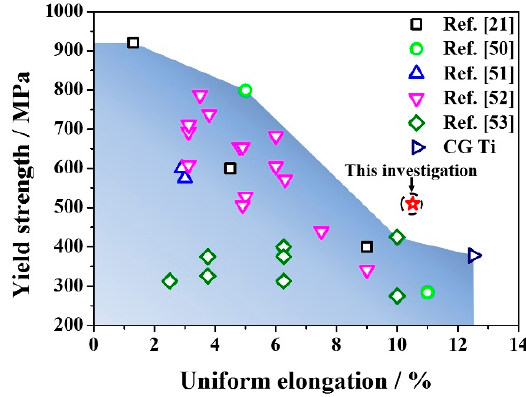
Figure 6. A plot of yield strength and uniform elongation for TA2 in present and other work from literatures [21,50–53].